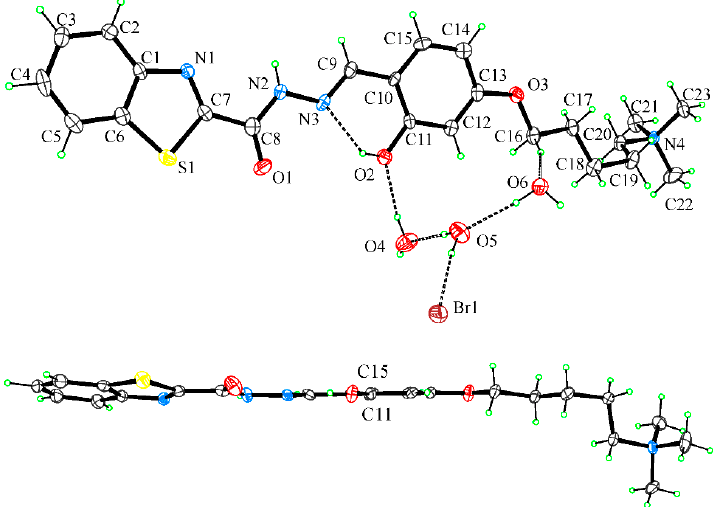
Figure 3. UP: Ortep view of BTABr normal to phenol ring with the H bonding pattern of H 2 O molecules drawn as dashed lines. DOWN: view of BTA + cation down the C11-C15 line. Thermal ellipsoids are drawn at 50% probability level.